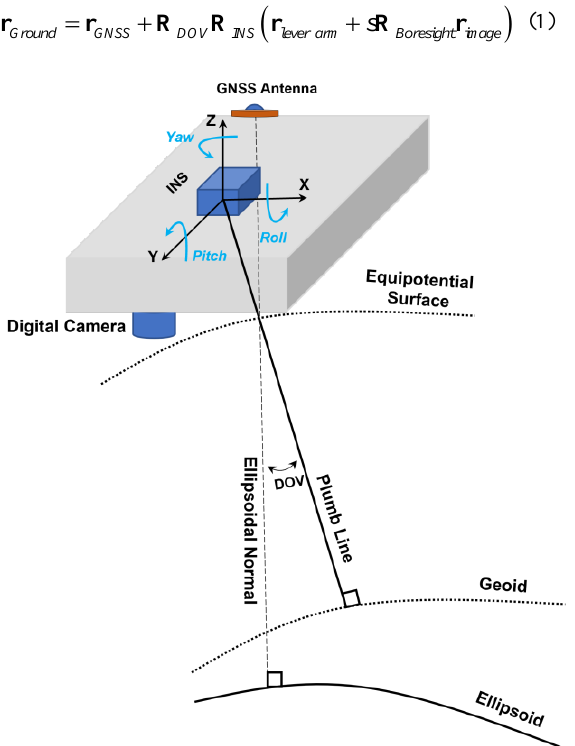
Figure 1. A schematic presentation of different aerial photogrammetry sensors and their relationship with geodetic reference